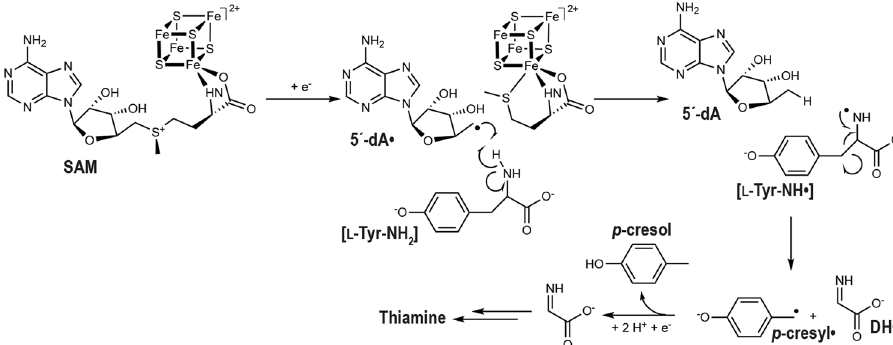
Fig. 1 Reaction catalyzed by ThiH in thiamine biosynthesis. Scheme of the reductive cleavage of S -adenosyl-L-methionine into L-methionine and the 5´-deoxyadenosyl radical. The latter abstracts a hydrogen atom from L-tyrosine to form p -cresyl • and